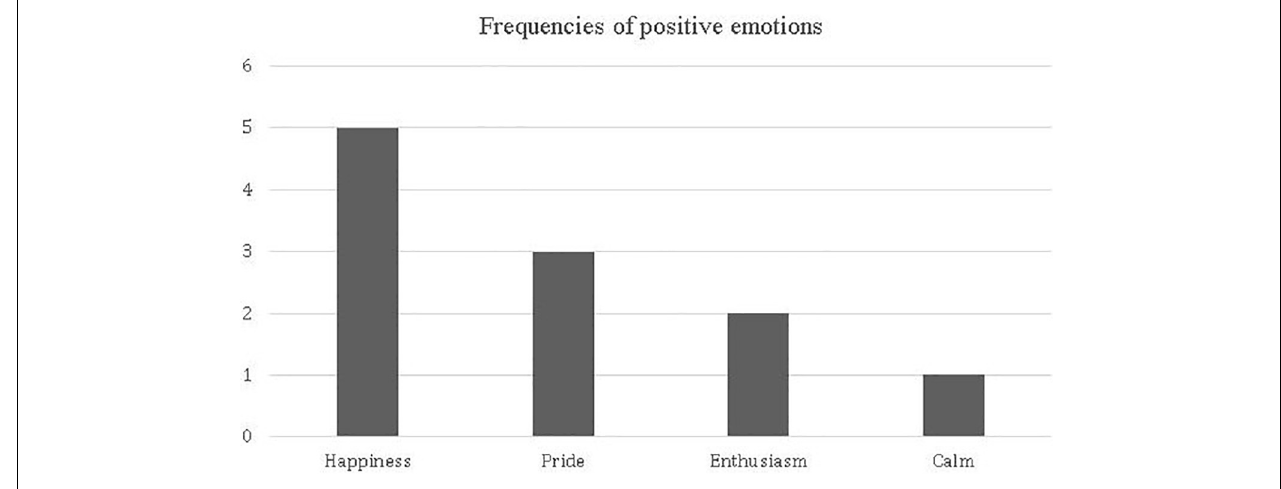
FIGURE 4 | Frequency of emotions of positive valence.